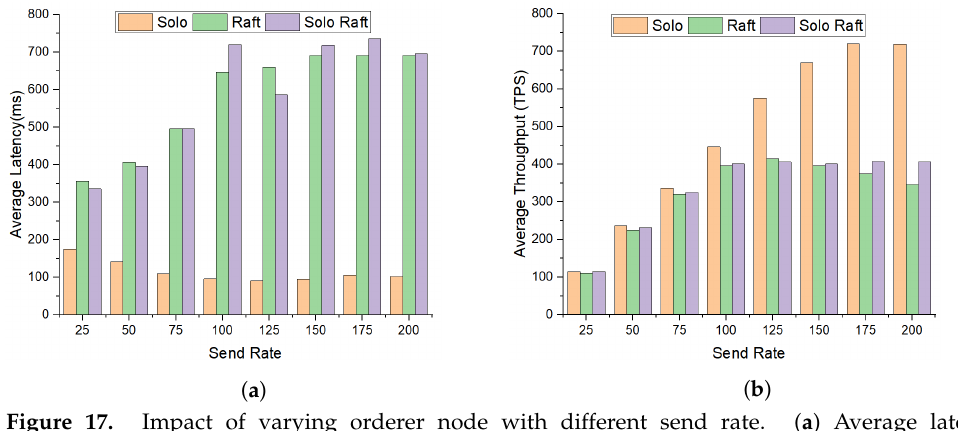
Figure 17. Impact of varying orderer node with different send rate. ( a ) Average latency; ( b ) average throughput. Table 5. Resource use analysis of proposed